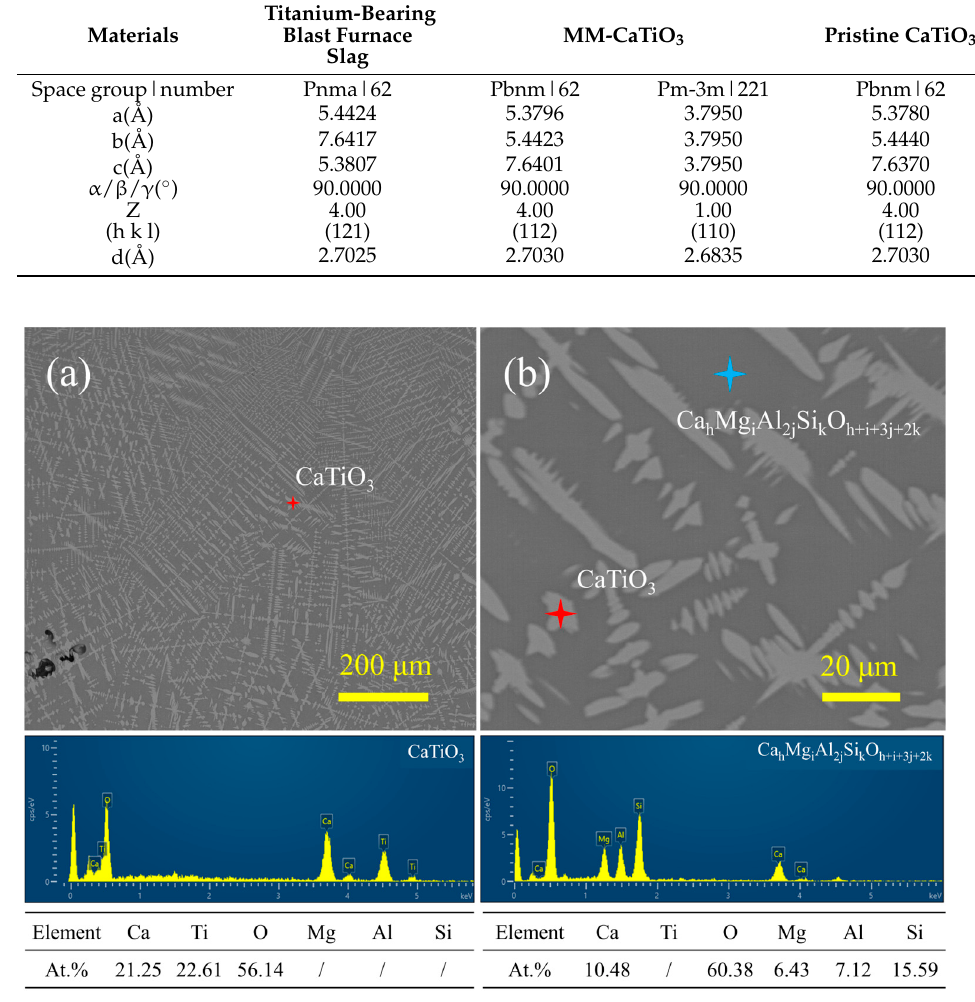
Figure 3. SEM-EDS analysis of MM-CaTiO 3 . ( a ) Mag. 300 × ; ( b ) mag. 2400 × Table 1. The la tt ice parameters of CaTiO 3 in various materials.